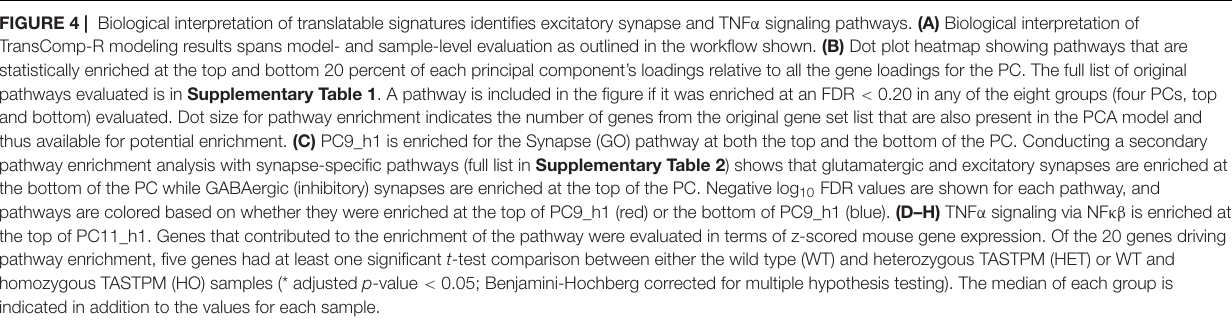
FIGURE 4 | Biological interpretation of translatable signatures identifies excitatory synapse and TNF α signaling pathways. (A) Biological interpretation of TransComp-R modeling results spans model- and sample-level evaluation as outlined in the workflow shown. (B) Dot plot heatmap showing pathways that are statistically enriched at the top and bottom 20 percent of each principal component’s loadings relative to all the gene loadings for the PC. The full list of original pathways evaluated is in Supplementary Table 1 . A pathway is included in the figure if it was enriched at an FDR < 0.20 in any of the eight groups (four PCs, top and bottom) evaluated. Dot size for pathway enrichment indicates the number of genes from the original gene set list that are also present in the PCA model and thus available for potential enrichment. (C) PC9_h1 is enriched for the Synapse (GO) pathway at both the top and the bottom of the PC. Conducting a secondary pathway enrichment analysis with synapse-specific pathways (full list in Supplementary Table 2 ) shows that glutamatergic and excitatory synapses are enriched at the bottom of the PC while GABAergic (inhibitory) synapses are enriched at the top of the PC. Negative log 10 FDR values are shown for each pathway, and pathways are colored based on whether they were enriched at the top of PC9_h1 (red) or the bottom of PC9_h1 (blue). (D–H) TNF α signaling via NF κβ is enriched at the top of PC11_h1. Genes that contributed to the enrichment of the pathway were evaluated in terms of z-scored mouse gene expression. Of the 20 genes driving pathway enrichment, five genes had at least one significant t -test comparison between either the wild type (WT) and heterozygous TASTPM (HET) or WT and homozygous TASTPM (HO) samples (* adjusted p -value < 0.05; Benjamini-Hochberg corrected for multiple hypothesis testing). The median of each group is indicated in addition to the values for each